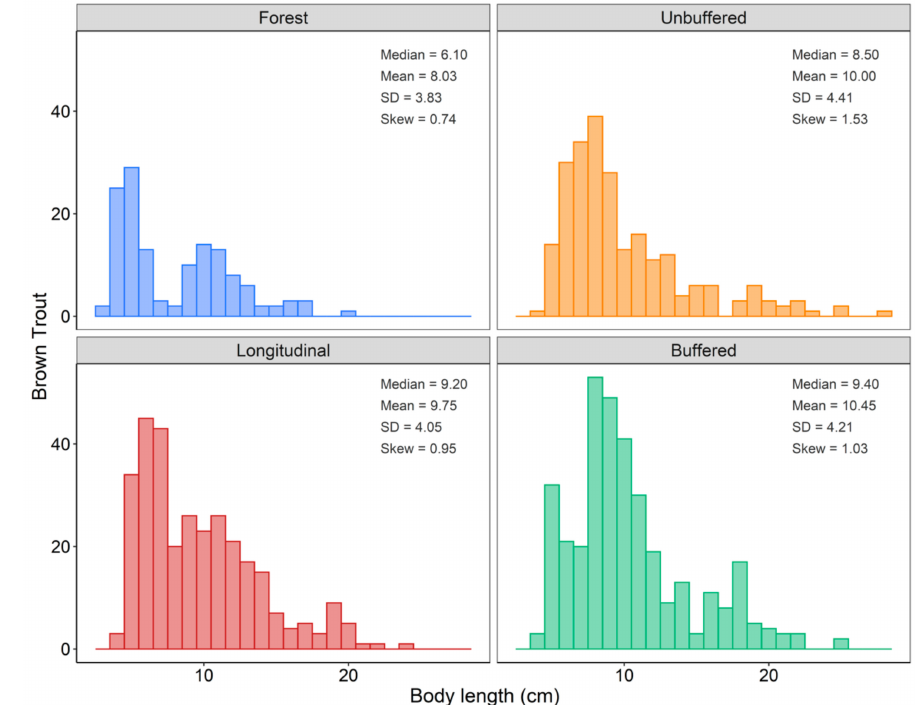
Figure 2. Histogram plots showing the distribution of brown trout (Salmo trutta) body lengths (cm) among the four site types: Pristine or least-impacted ‘Reference’ sites (=Forest) that were typically located further upstream due to urbanization in lower reaches, site pairs with an ‘Unbuffered’ upstream site and a downstream ‘Buffered’ site with a woody riparian buffer on both banks, and ‘Longitudinal’ sites that were typically located further downstream from the other site types to capture cumulative impacts of urban land uses. Mean and SD, median, and skewness of each site type are given in each panel.